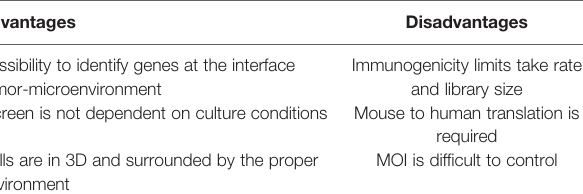
TABLE 3 | DIVoS: advantages and